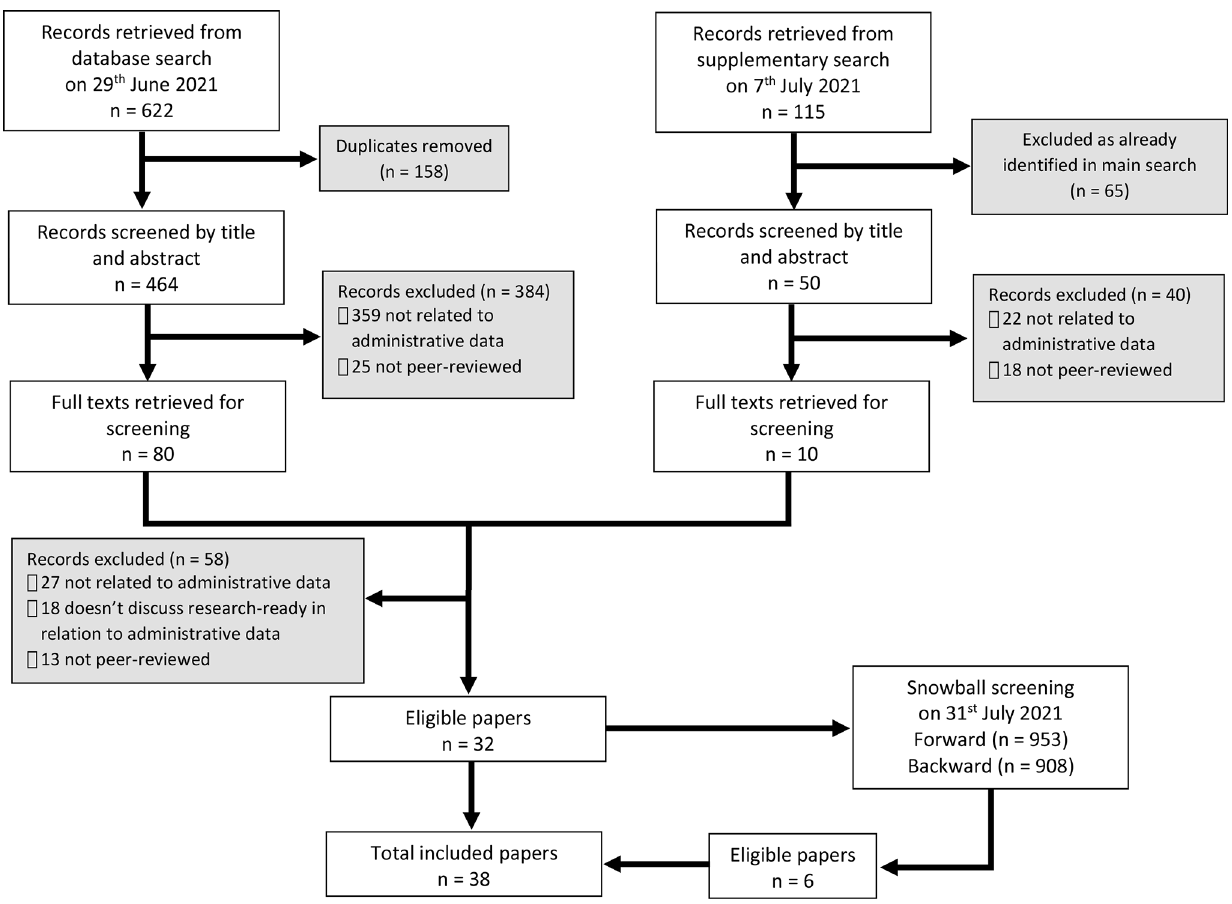
Figure 1: Flow diagram of study